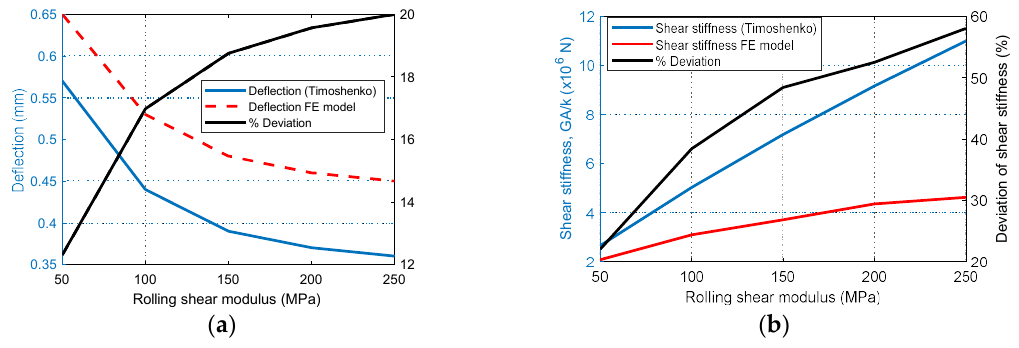
Figure 9. Variation of ( a ) deflection and ( b ) shear stiffness of the section of panel with length to depth ratio of 11.11.